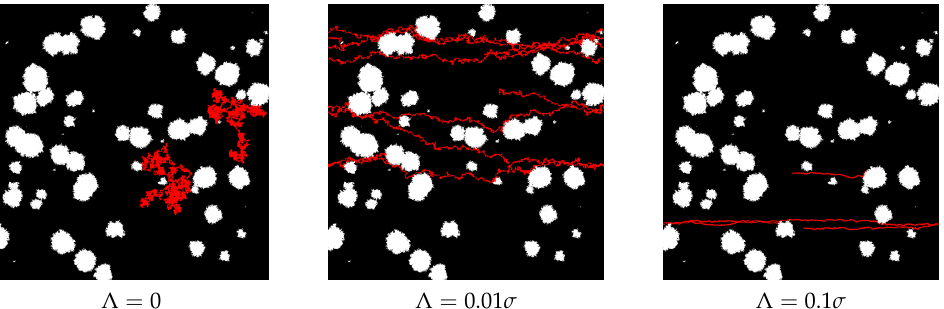
Figure 9. Exemplary trajectories of two diffusing particles without drift Λ = 0, and with two different values of drift Λ = 0.01 σ and Λ = 0.1 σ . Here, σ = 0.05 and trajectory length t = 10 7 . Note the periodic boundary